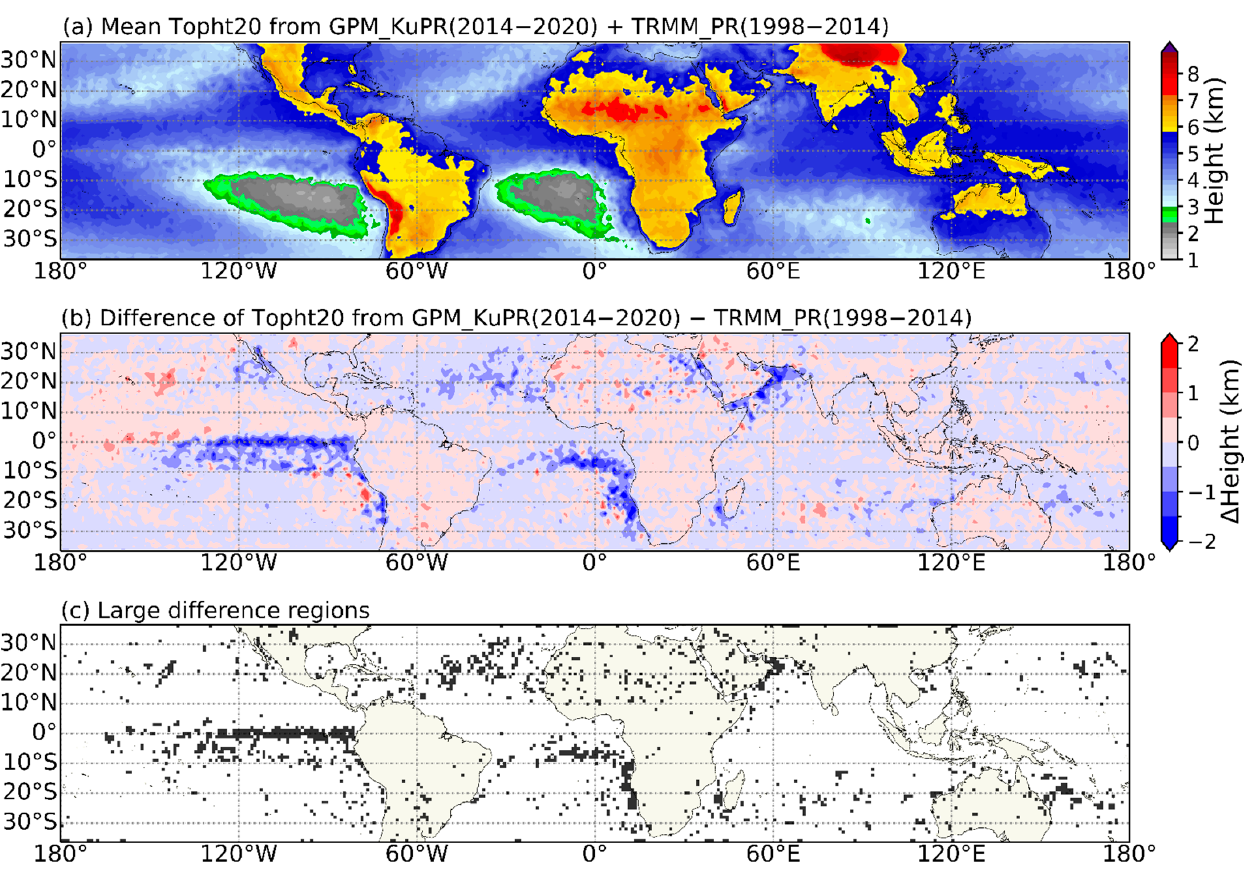
Figure 11. Global distribution (1° × 1°) of ( a ) mean Topht20 from the combination of the TRMM_PR and GPM_KuPR during 1998–2020, ( b ) Topht20 difference of the GPM_KuPR (2014–2020) minus TRMM_PR (1998–2014), and ( c ) large-difference grids (black points) with absolute difference value greater than its standard deviation and 0.5 km threshold.